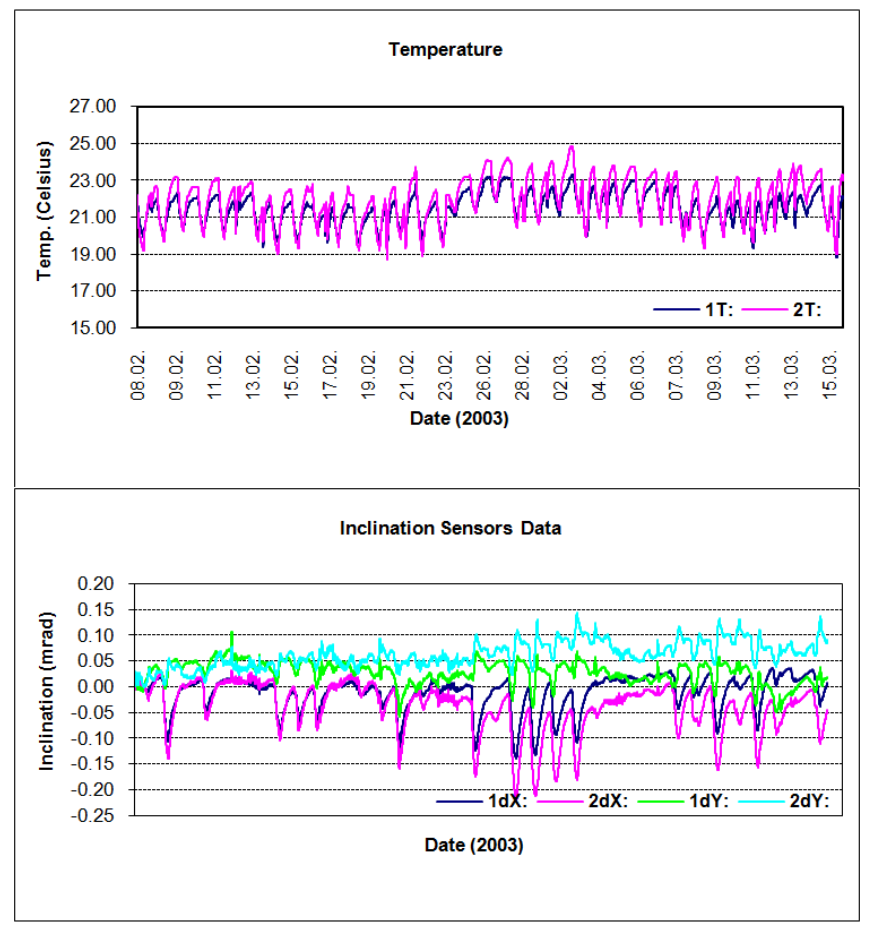
Figure 6. Temperature changes and inclinations of the tall building from 8 February to 15 March 2003.